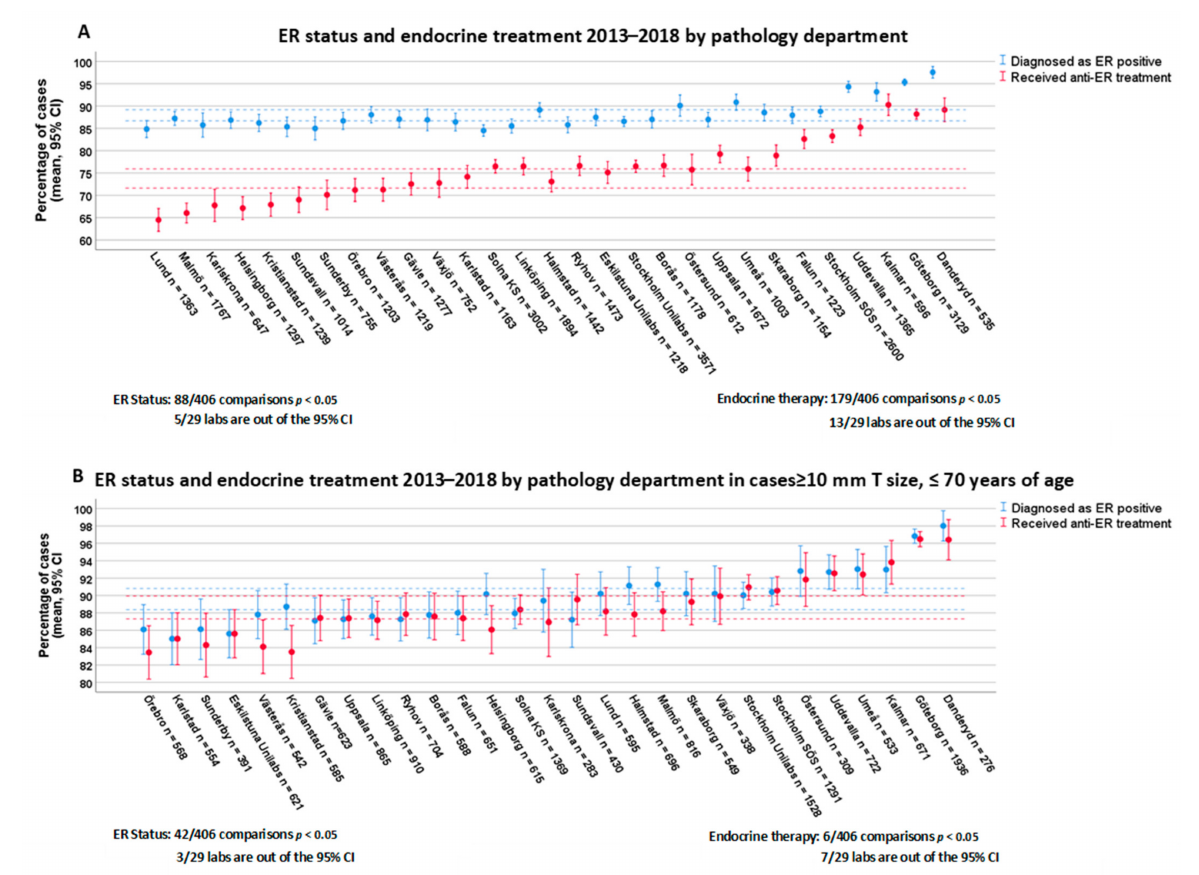
Figure 1. Endocrine receptor (ER) status and endocrine treatment between 2013 and 2018 by department. Dashed lines represent the CI for overall positivity (blue) and overall treatment rate (red). ( A ) includes all the patients while ( B ) shows results with cases ≥ 10 mm T size, ≤ 70 years of age.